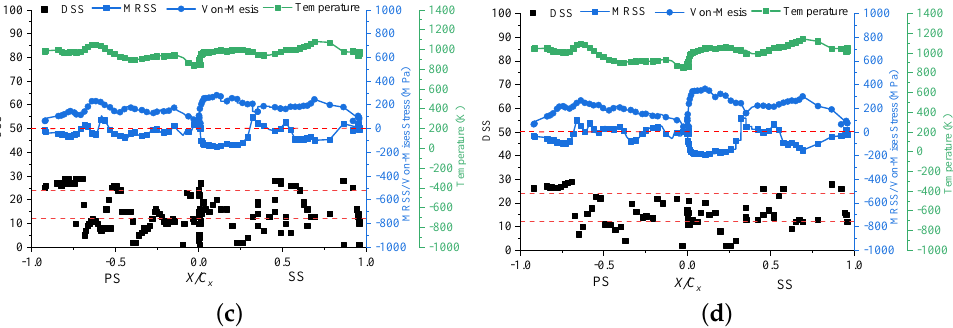
Figure 13. Distribution of temperature, DSS, von Mises stress, and MRSS on the outer surface of the blade: ( a ) 10% span and ( c ) 50% span under the rotating condition; ( b ) 10% span and ( d ) 50% span under the stationary